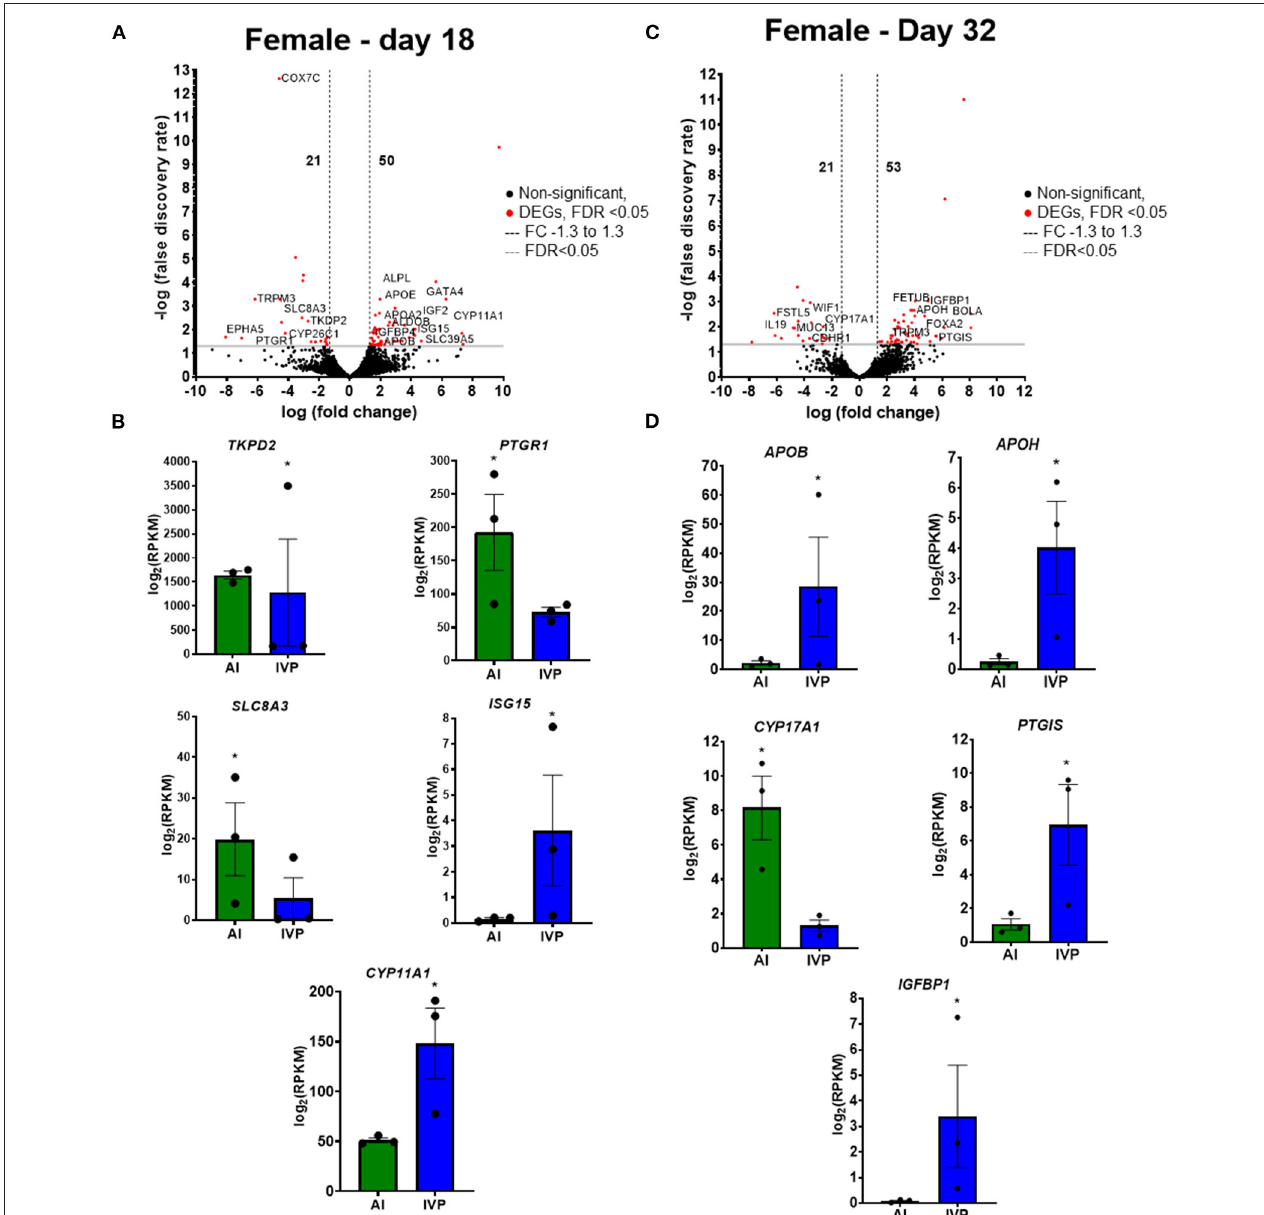
FIGURE 5 | Differentially expressed genes (DEGs) in female conceptuses on day 18 and in female placentas on day 32. (A) Volcano plot representing the number of DEGs comparing IVP vs AI on day 18 conceptuses. Black dots are not significant (FDR > 0.05), Red dots are significant (FDR < 0.05), Gray line at FDR = 0.05, Black dashed lines delimit FC − 1.3 to 1.3. Representative DEGs of important roles during this time period are shown in (B) . (C) Volcano plot representing the number of DEGs comparing IVP vs AI on day 32 conceptuses. Black dots are not significant (FDR > 0.05), Red dots are significant (FDR < 0.05), Gray line at FDR = 0.05, Black dashed lines delimit FC − 1.3 to 1.3. Some representative DEGs of important roles during this time period are shown in (D) . *FDR < 0.05. AI, artificial insemination; IVP, in vitro produced